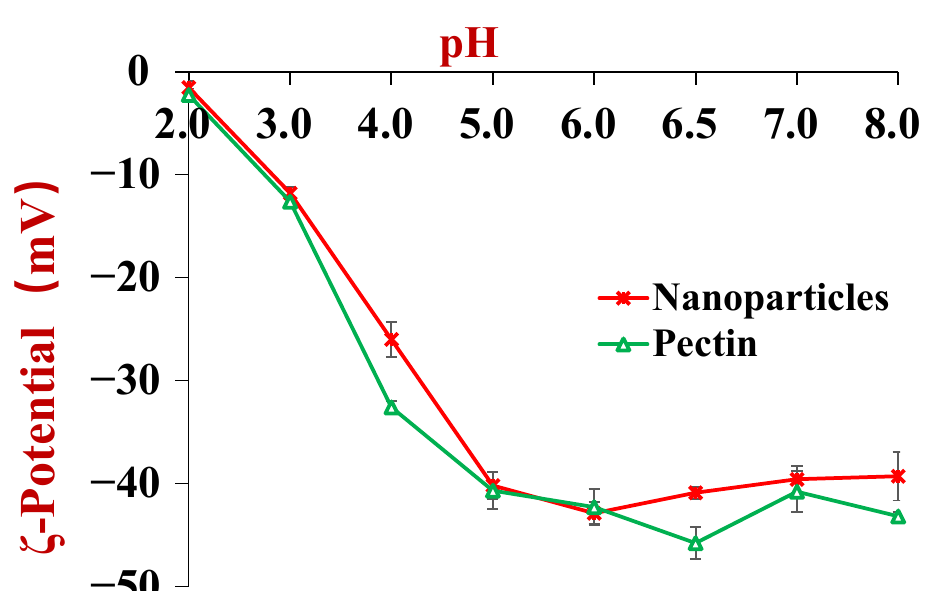
Figure 4. The ζ -potential of tannic acid and resveratrol co-encapsulated zein/pectin nanoparticles at pH values ranging from 2.0 to 8.0.